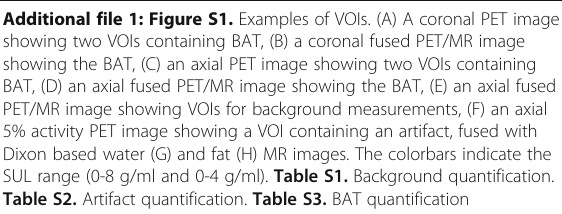
Additional file 1: Figure S1. Examples of VOIs. (A) A coronal PET image showing two VOIs containing BAT, (B) a coronal fused PET/MR image showing the BAT, (C) an axial PET image showing two VOIs containing BAT, (D) an axial fused PET/MR image showing the BAT, (E) an axial fused PET/MR image showing VOIs for background measurements, (F) an axial 5% activity PET image showing a VOI containing an artifact, fused with Dixon based water (G) and fat (H) MR images. The colorbars indicate the SUL range (0-8 g/ml and 0-4 g/ml). Table S1. Background quantification. Table S2. Artifact quantification. Table S3. BAT quantification Abbreviations %diff: Percentage difference; 18 F-FDG: Glucose analog tracer labeled with fluorine-18, (2-deoxy-2-( 18 F)fluoro-D-glucose); 3D: Three dimensional; AC: Attenuation correction; ASL: Arterial spin labeling; ATP: Adenosine triphosphate; BARCIST: Brown Adipose Reporting Criteria in Imaging Studies; BAT: Brown adipose tissue; BMV: BAT metabolic volume; BOLD: Blood- oxygen-level-dependent; CT: Computed tomography; DCE-MRI: Dynamic contrast-enhanced MRI; DWI: Diffusion weighted MR imaging; FoV: Field-of- view; IDEAL-IQ: Iterative decomposition with echo-asymmetry and least squares estimation; IVIM: Intravoxel incoherent motion; MR: Magnetic resonance; OSEM: Ordered subset expectation maximization; PCa: Prostate cancer; PDFF: Proton-density fat fraction; PET: Positron emission